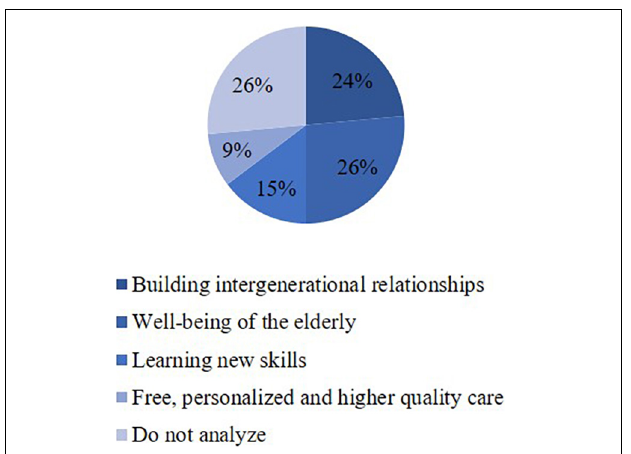
FIGURE 3 | Frequency of coded segments in each category: older people’s